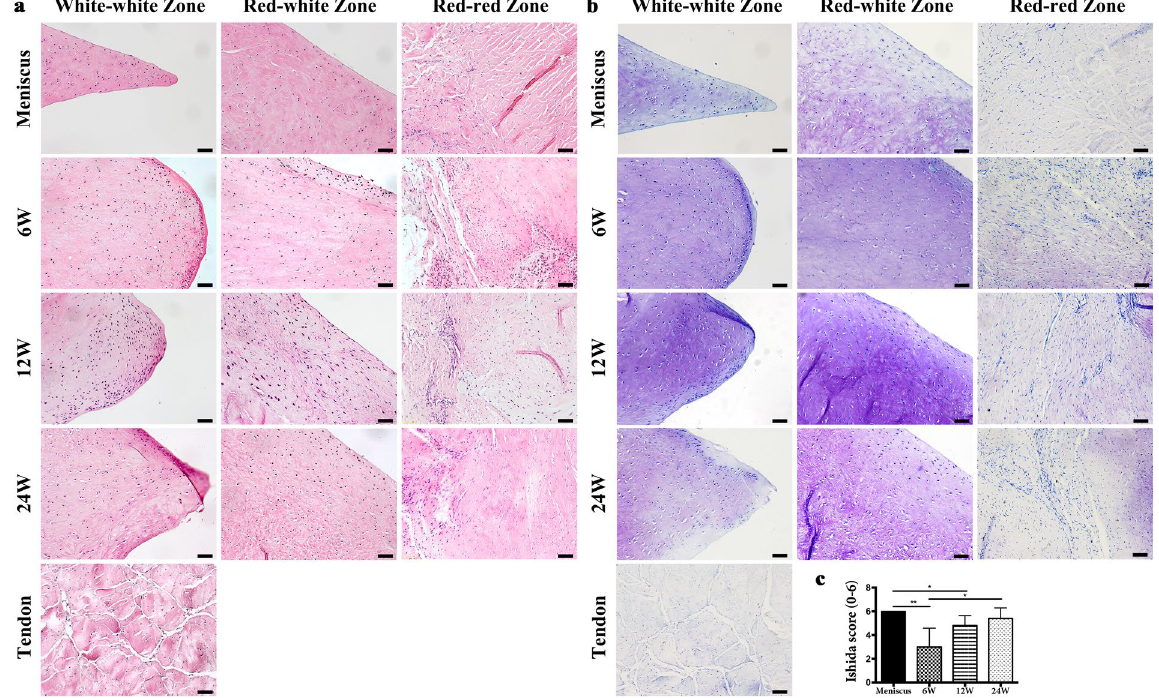
Figure 5. H&E staining, toluidine blue staining and Ishida score of native meniscus, native tendon and regenerated meniscus at 6, 12 and 24 weeks post-operative of transplantation group in white-white zone, red- white zone and red-red zone. Scale bar = 50 μ m. ( a ) HE staining. ( b ) Toluidine blue staining. ( c ) Ishida score.